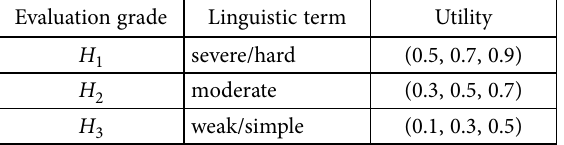
Table 1. FBS scale used for delay causes evaluation Evaluation grade Linguistic term